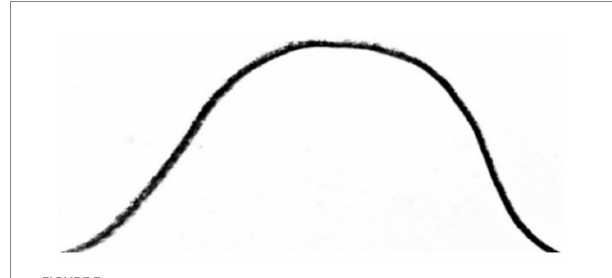
FIGURE 3 Hand-drawn graphical representation of the function f(x) = − x 2